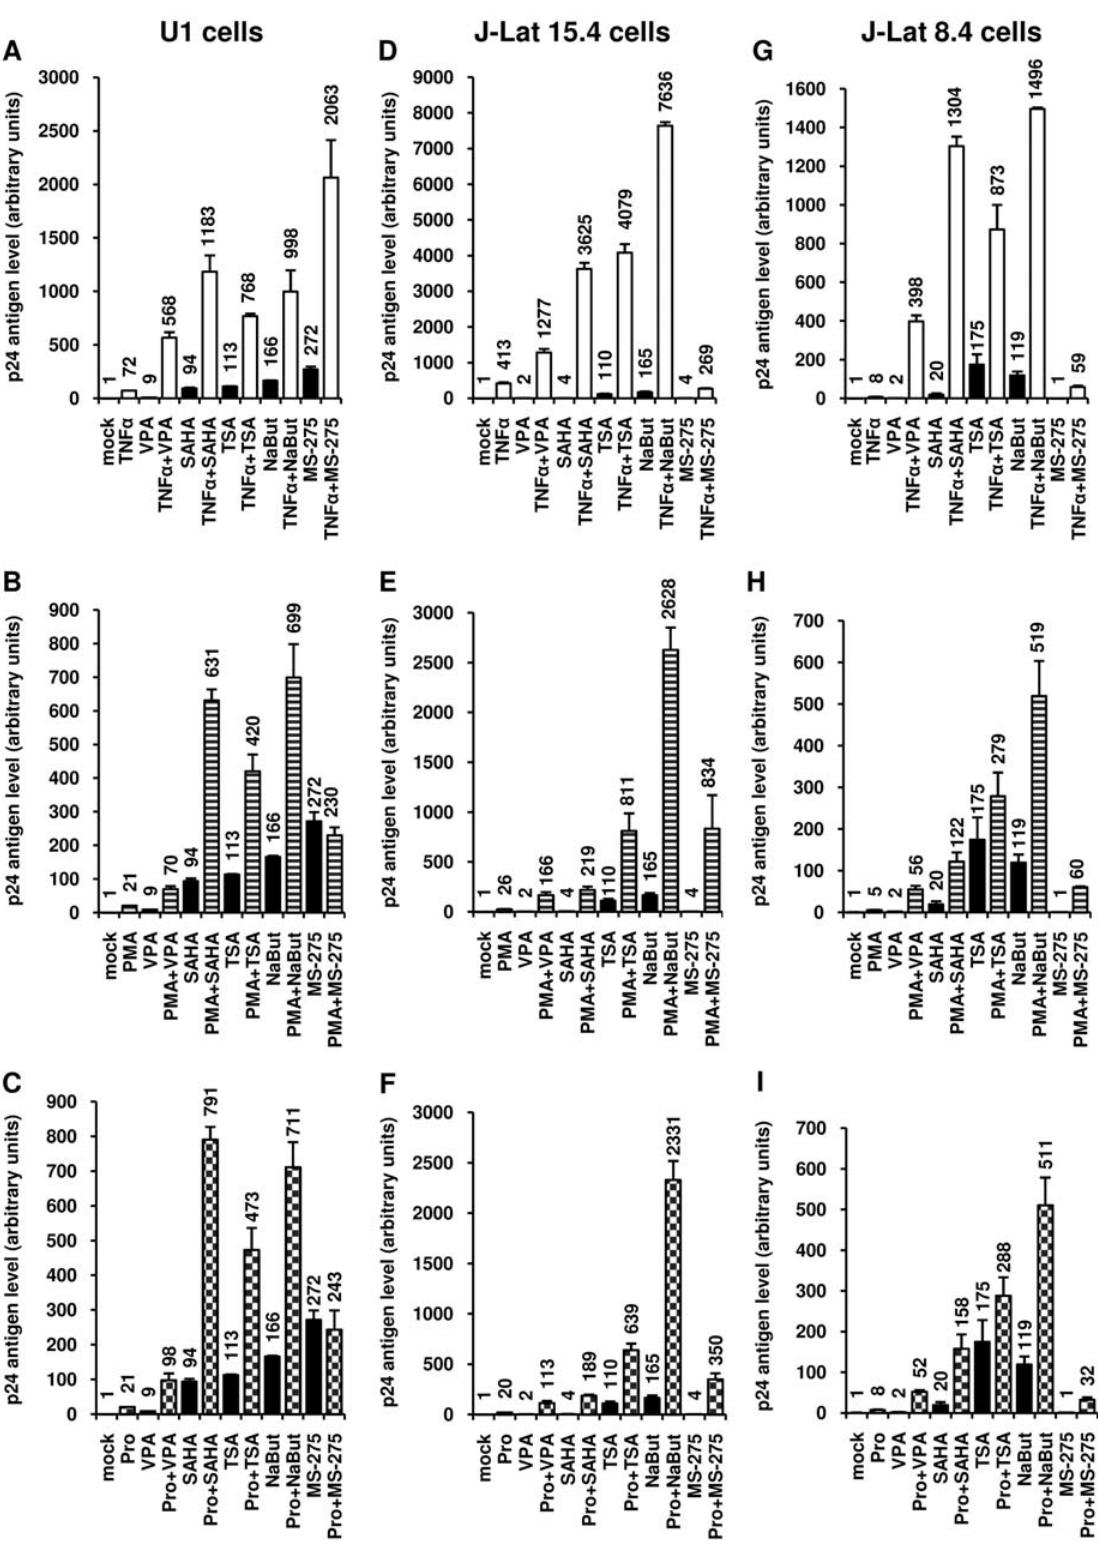
Figure 2. Synergistic activation of HIV-1 production by prostratin and clinically used HDACIs. U1 (panels A , B and C ), J-Lat 15.4 (panels D , E and F ) or J-Lat 8.4 (panels G , H and I ) cells were mock-treated or treated with TNF a (10 ng/ml) (panels A , D and G ), PMA (20 nM) (panels B , E and H ), prostratin (5 m M) (panels C , F and I ) alone or in combination with different HDACIs [VPA (2.5 mM), SAHA (2.5 m M), TSA (500 nM), NaBut (5 mM) or MS-275 (5 m M)]. At 24 h posttreatment, viral production was estimated by measuring CA-p24 antigen concentration in culture supernatants. The mock-treated value was arbitrarily set at a value of 1. Each value is the mean 6 SE from two (for the J-Lat 15.4 and 8.4 cell lines) or three (for the U1 cell lines) separate experiments performed in triplicate. doi:10.1371/journal.pone.0006093.g002 PLoS ONE |